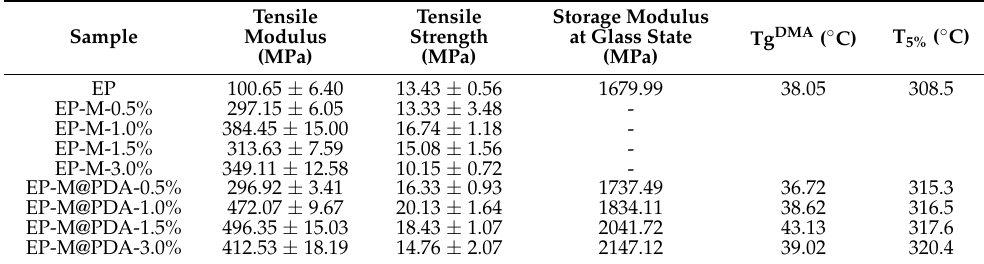
Figure 5. SEM images of fracture surfaces for ( a ) EP. ( b ) EP-M-3.0%. ( c ) and ( d ) EP-M@PDA-3%. Table 1. Physical Properties of epoxy